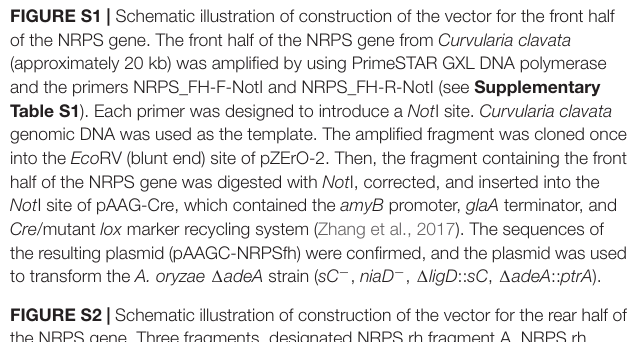
FIGURE S1 | Schematic illustration of construction of the vector for the front half of the NRPS gene. The front half of the NRPS gene from Curvularia clavata